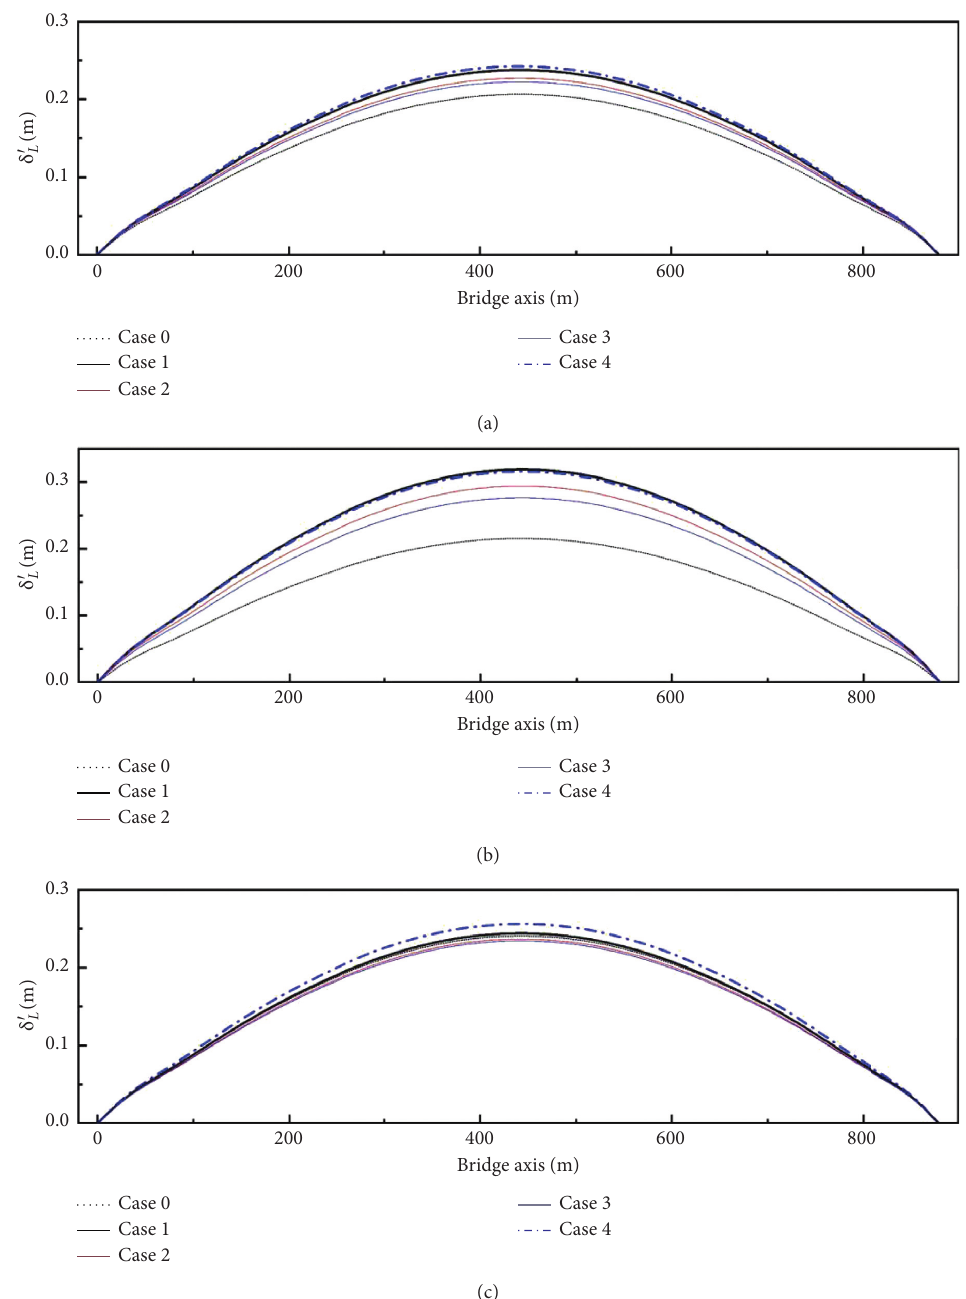
Figure 19: RMS lateral buffeting displacements of all the investigated cases at different AoAs: (a) AoA � 0 ° ; (b) AoA � +5 ° ; (c) AoA � − 5 °